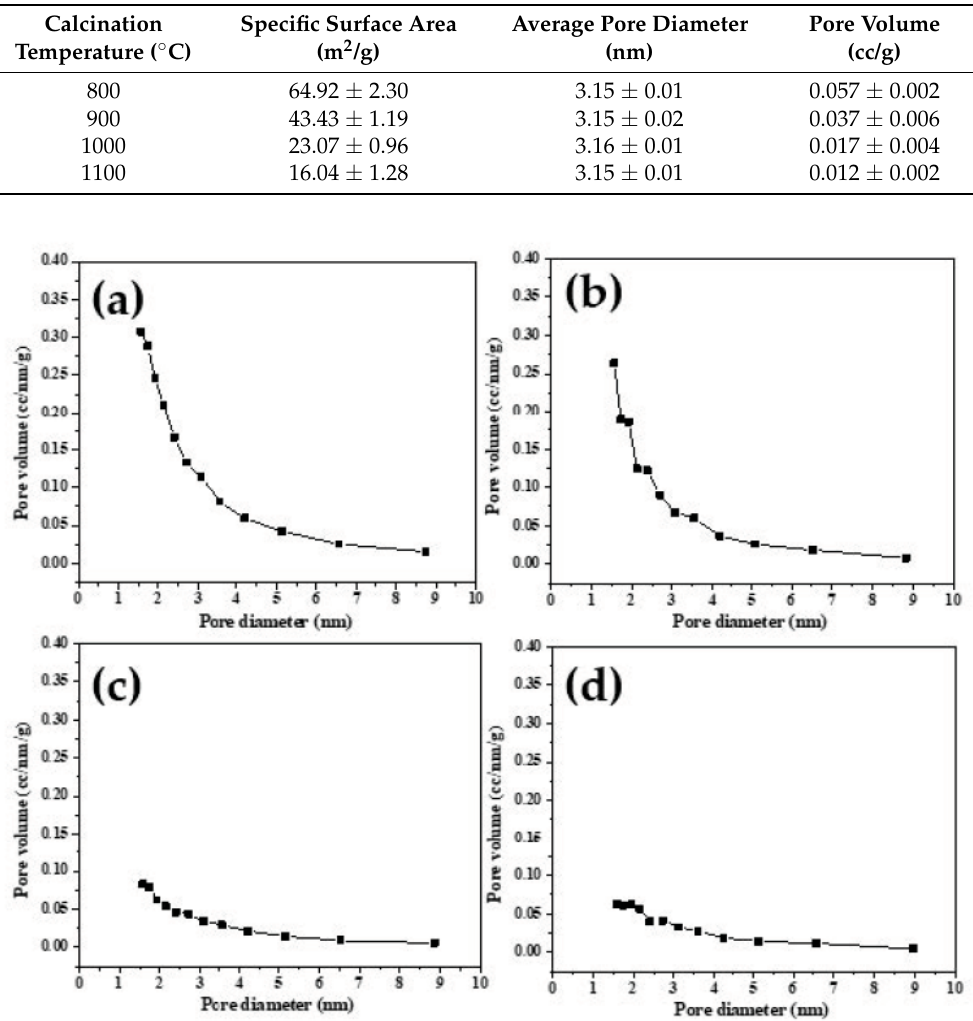
Figure 4. Pore size distributions of β -TCP powders calcined at temperatures of ( a ) 800, ( b ) 900, ( c ) 1000, and ( d ) 1100 °C. Table 1. Specific surface area, average pore diameter, and pore volume of β -TCP powders calcined at temperatures of 800, 900, 1000, and 1100 °C.